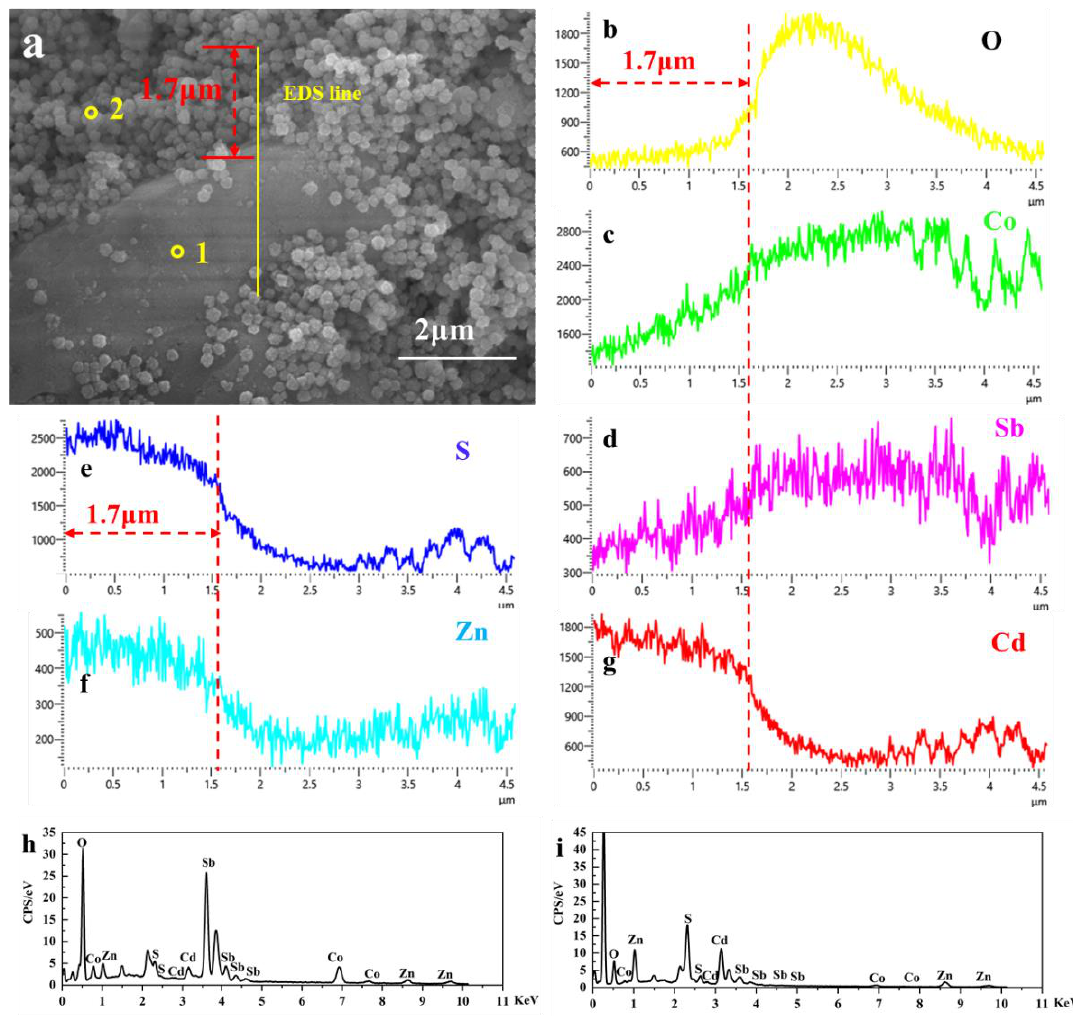
Figure 6. The element distribution along the EDS line in ( a ), (( b ): O, ( c ): Co, ( d ): Sb, ( e ): S, ( f ): Zn, and ( g ): Cd) and EDS results of point 1 ( h ) and point 2 ( i ) in ( a ).